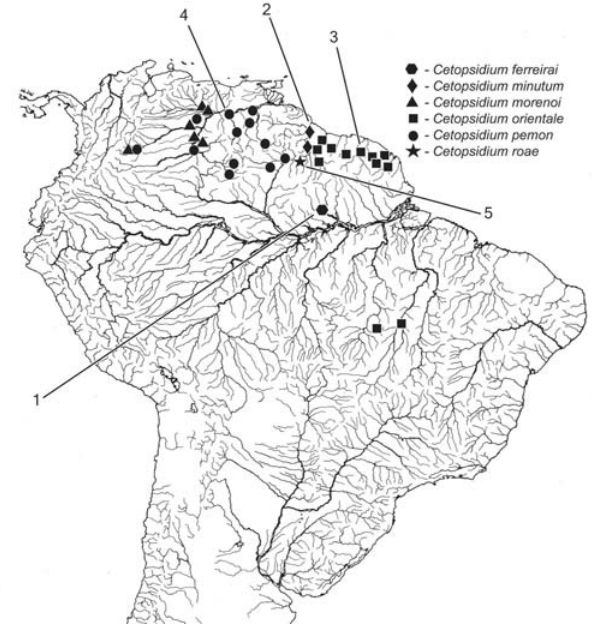
Fig. 2. Map of central and northern South America showing geographic distribution of Cetopsidium ferreirai (1 = holo- type locality), Cetopsidium minutum (2 = holotype locality of Hemicetopsis minutus ), Cetopsidium morenoi , Cetopsidium orientale (3 = holotype locality of Pseudocetopsis orientale ), Cetopsidium pemon (4 = holotype locality), and Cetopsidium roae (5 = holotype locality) (some symbols represent more that one locality and/or lot of